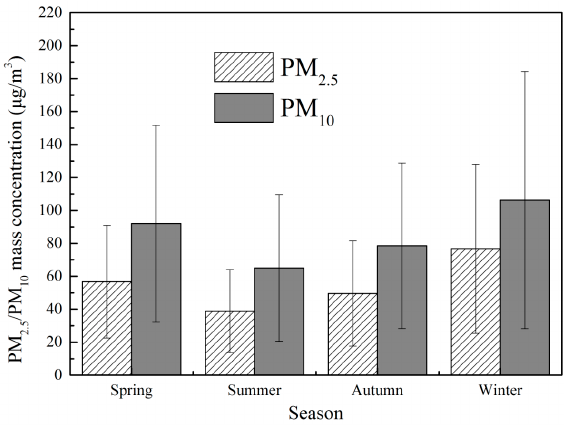
Figure 9. Seasonal variations of PM 2.5 and PM 10 in Hangzhou City for 2014–2016.